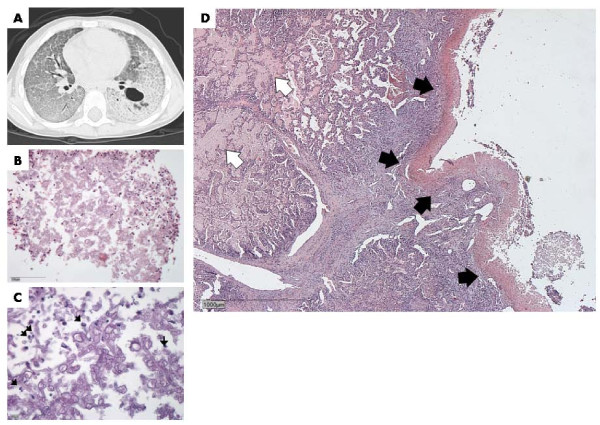
Clinical complication. At age 5 years a chest CT (Figure. 5 A) showed a cavity and infiltration in the left lower lobe which was due to an infection with Aspergillus fumigatus; the resected specimen showed an aspergilloma (black arrows) in the neighborhood of typical alveolar proteinosis with surfactant filled alveoli (white arrows)(Figure. 5 D). Inside the cavity a neutrophilic infiltrate (Figure. 5 B) and infection with aspergillus (Figure. 5 C, almost all fungi, arrows indicate neutrophils) was present.